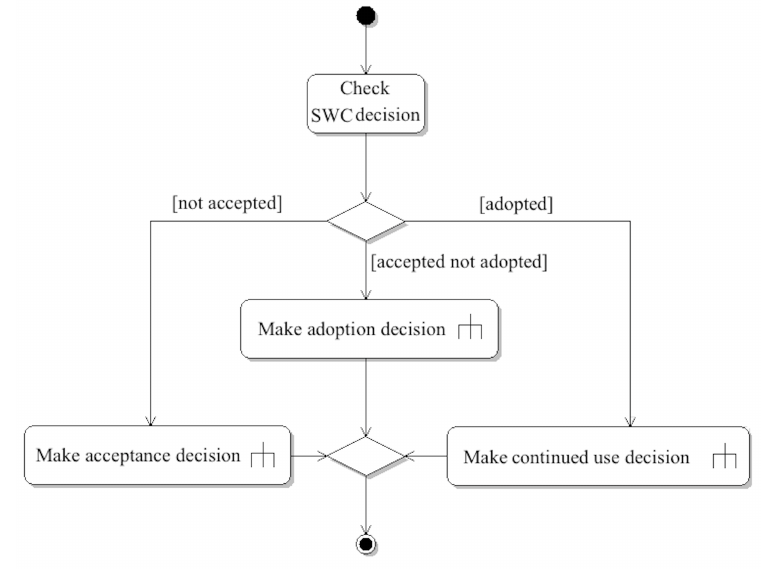
Figure 1. Farmer agents’ basic